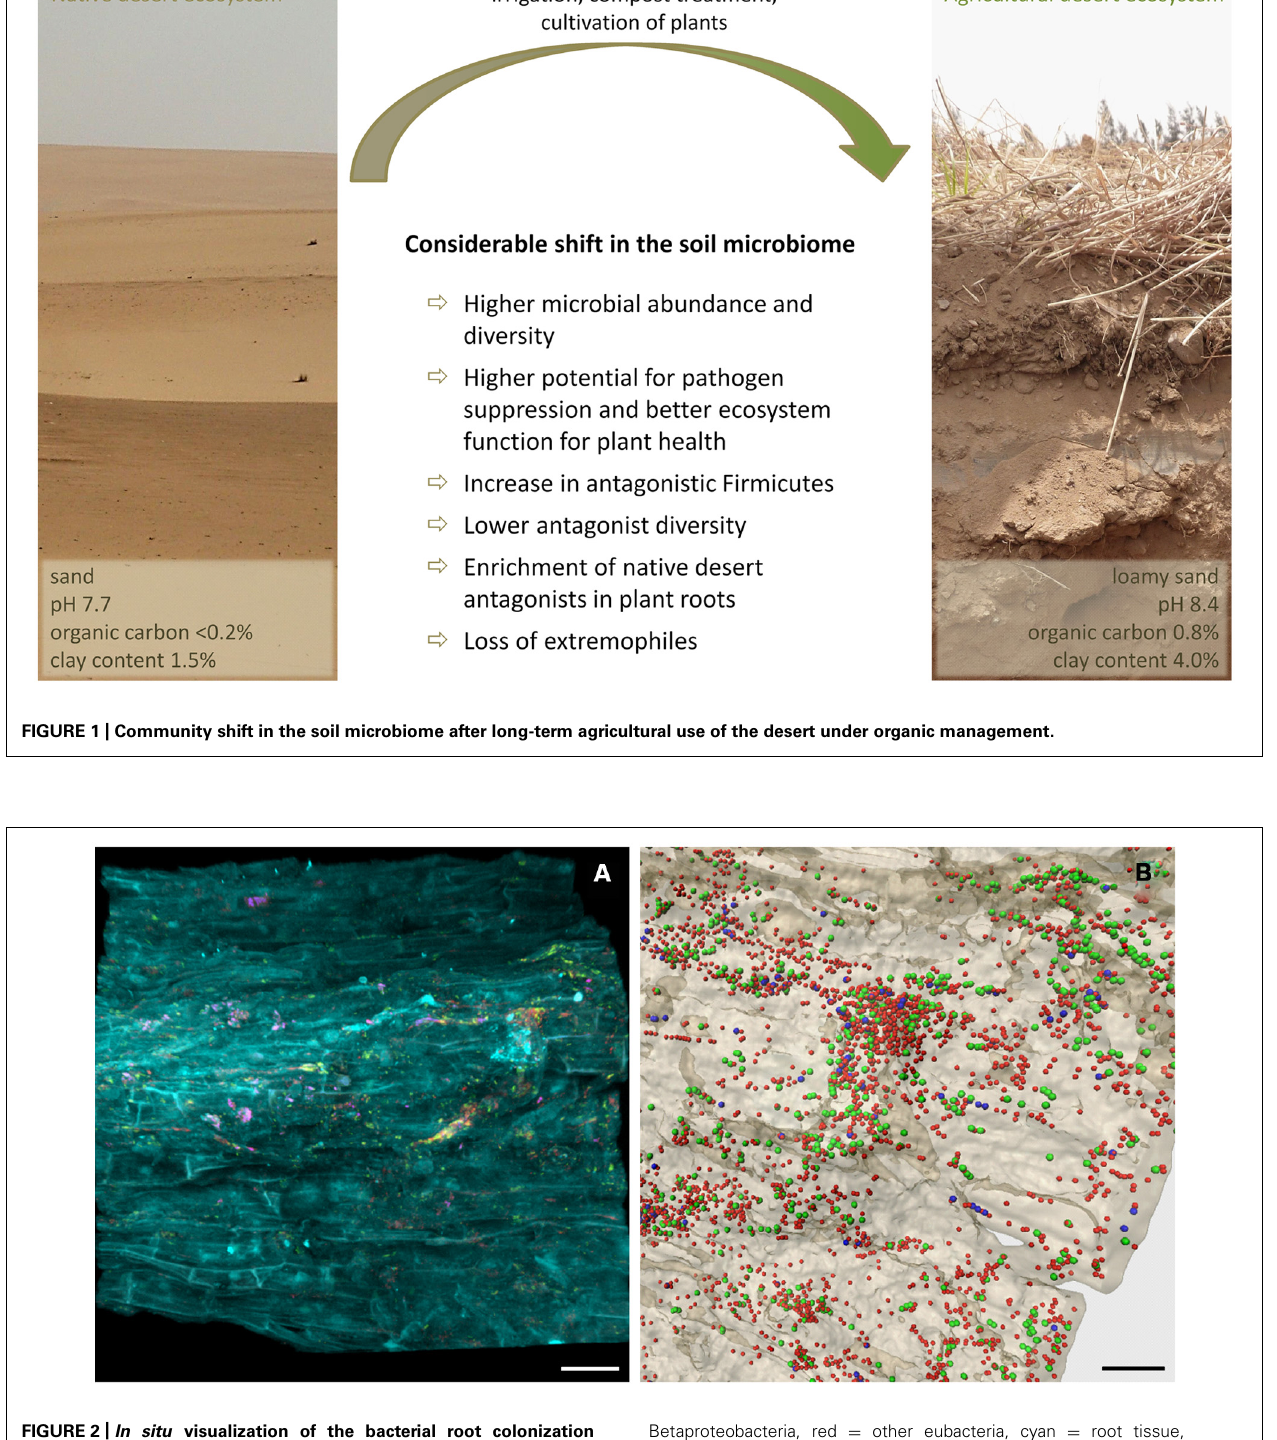
Betaproteobacteria, red = other eubacteria, cyan = root tissue, scale bar = 30 μ m. (B) green = Alphaproteobacteria, blue = Betaproteobacteria, red = other eubacteria, beige = root tissue, scale bar = 15 μ m.